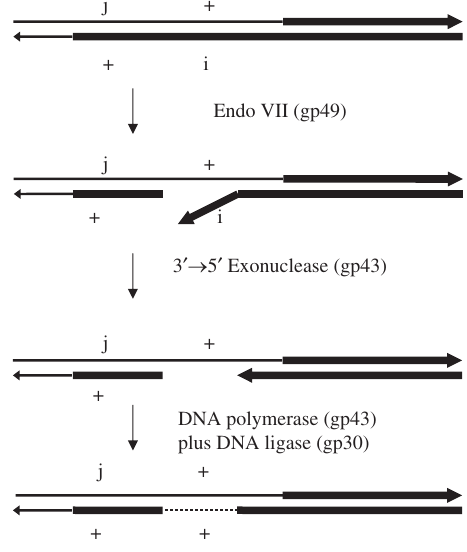
Figure 7 Schematic of the MMR pathway in bacteriophage T4 (76 – 78) .